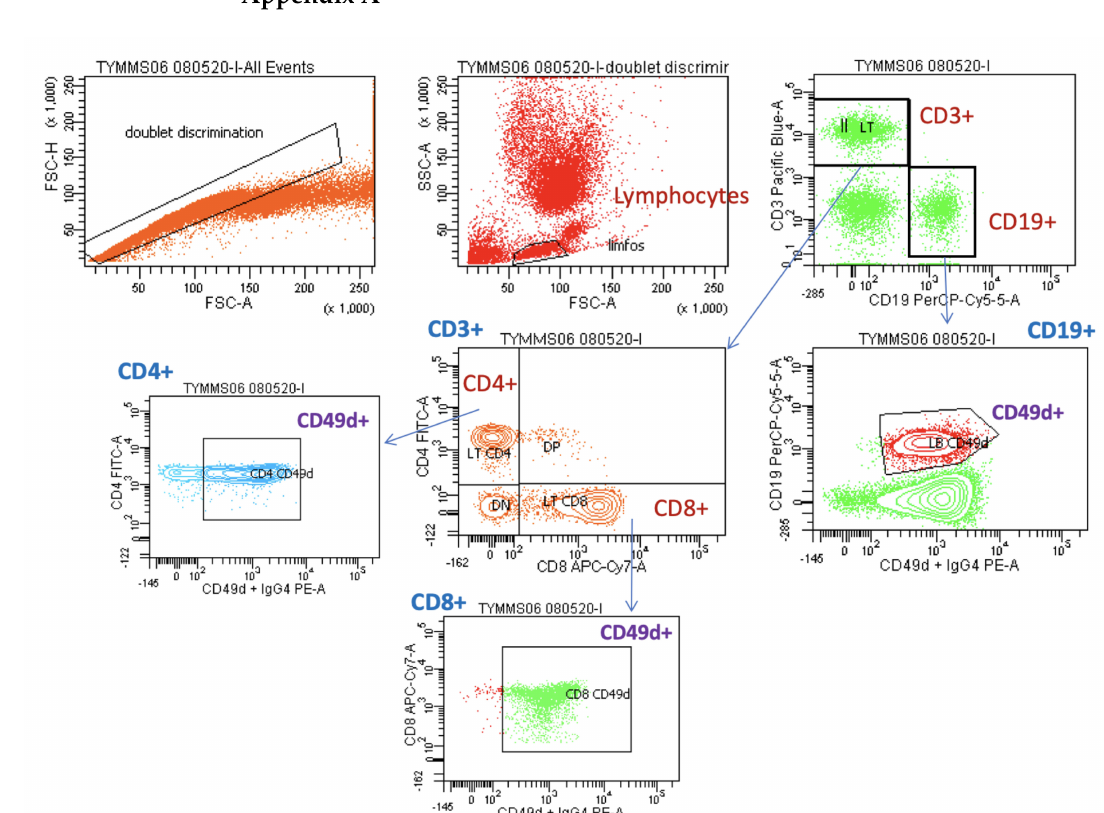
Figure A1. Analysis strategy of the Whole Blood protocol.